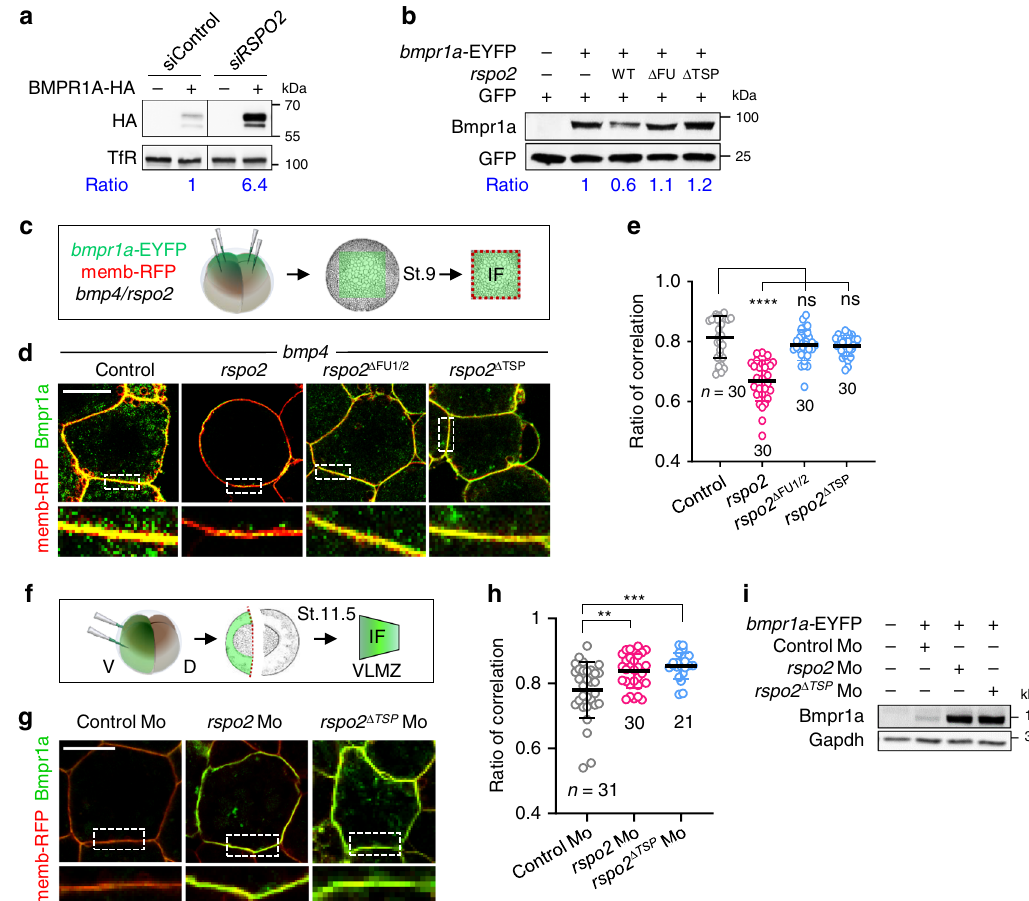
Fig. 6 RSPO2 removes cell surface BMPR1A. a Western blot analysis in H1581 cells treated with siControl or si RSPO2 as indicated and transfected with or without BMPR1A-HA DNA. Transferrin receptor (TfR), a loading control. Ratio, relative levels of BMPR1A-HA normalized to TfR. Data shows representative result from 3 independent experiments with similar conclusion. b Western blot analysis of Bmpr1a in Xenopus laevis (St. 15) neurulae injected animally at 2- cell to 4-cell stages as indicated. GFP mRNA was injected as an injection control. Ratio, relative levels of Bmpr1a normalized to GFP. Data shows representative result from 3 independent experiments with similar conclusion. c Scheme for immuno fl uorescence microscopy (IF) in Xenopus laevis